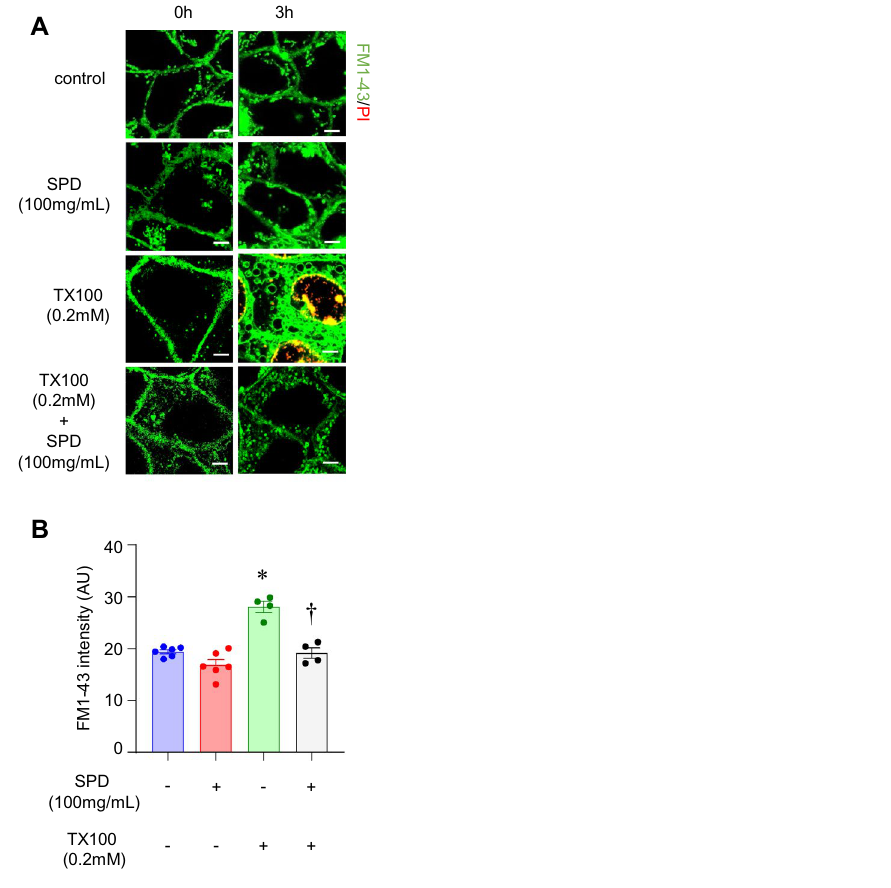
Figure 4. SPD protects against TX100-induced plasma membrane damage. Human keratinocytes (HaCaT) were exposed to TX100 (0.2 mM) for 3 h in presence of SPD (100 mg/ml). Cells were stained with FM1-43 and subjected to microscopy. ( A , B ) Representative microscopic images and quantification of intensity of FM1-43 was assessed by confocal microscopy. Scale, 5 µm. Data represent mean ± SEM (n = 4–6). * p < 0.05 compared to control (TX100-untreated). † p < 0.05 compared to TX100-treated